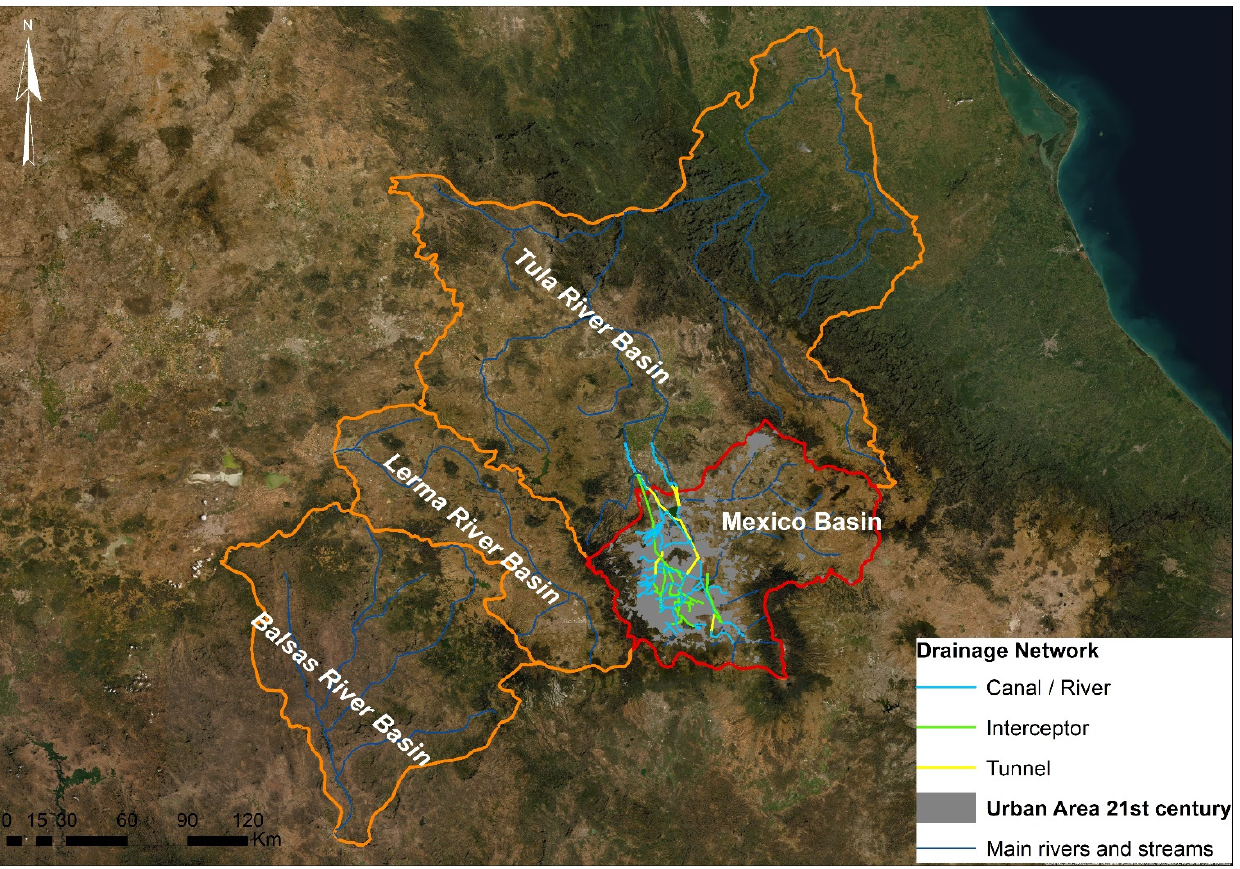
Figure 4 . Megabasin created by alterations in the Basin of Mexico throughout history. Figure 4. Megabasin created by alterations in the Basin of Mexico throughout history. Own elabora- tion based on data from CONABIO